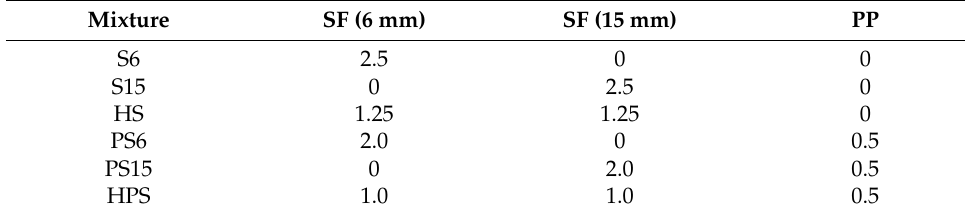
Table 1. Fiber contents of the six HPC mixtures.